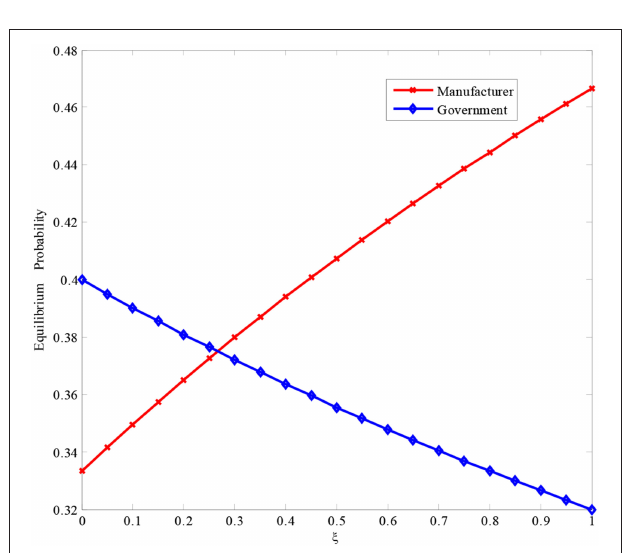
FIGURE 5 | Game members’ equilibrium probabilities as a function of ξ